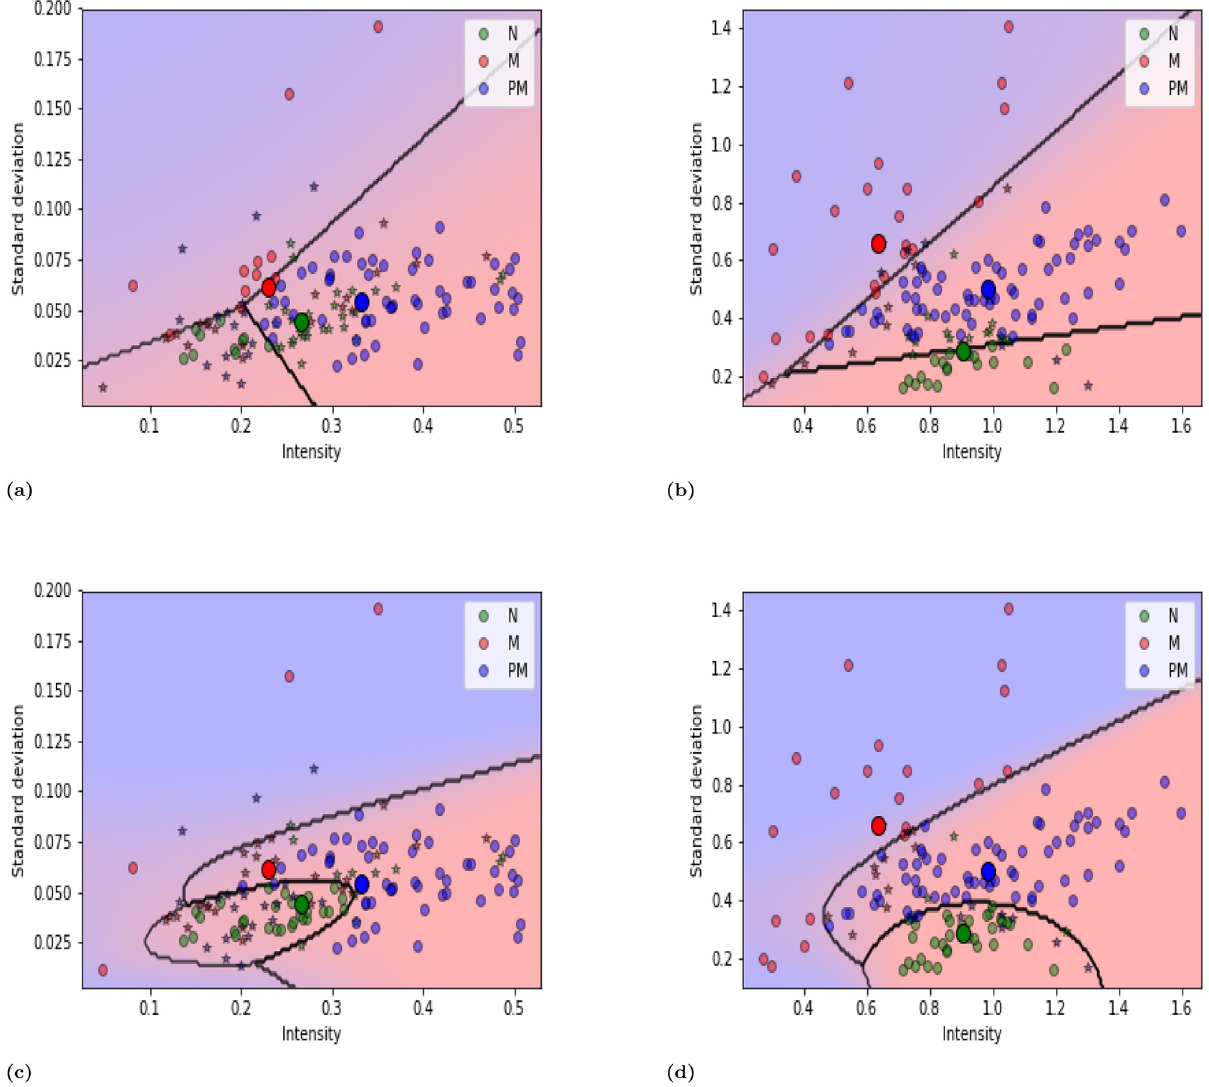
Fig 4. For buccal mucosa (a) Un-normalized and (b) Normalized data were plotted using LDA classifier, whereas (c) Un-normalized and (d) normalized data were plotted using QDA classifier. The misclassification exhibited as a star and the big dark circles represented the mean of each class. The results showed that the linear boundary ((a) and (b)) and quadratic boundary ((c) and (d)) can discriminate among normal (N), malignant (M) and premalignant lesions (PM).